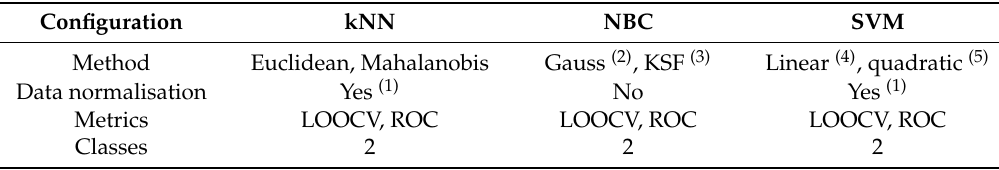
Table 2. kNN, NBC and SVM configuration